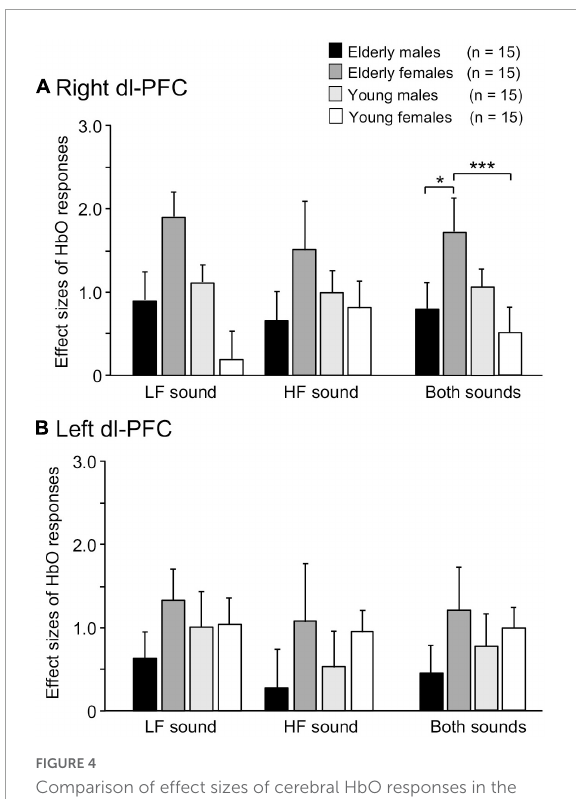
FIGURE4 Comparison of effect sizes of cerebral HbO responses in the right (A) and left (B) dl-PFC. *, ***, p < 0.05, 0.001,